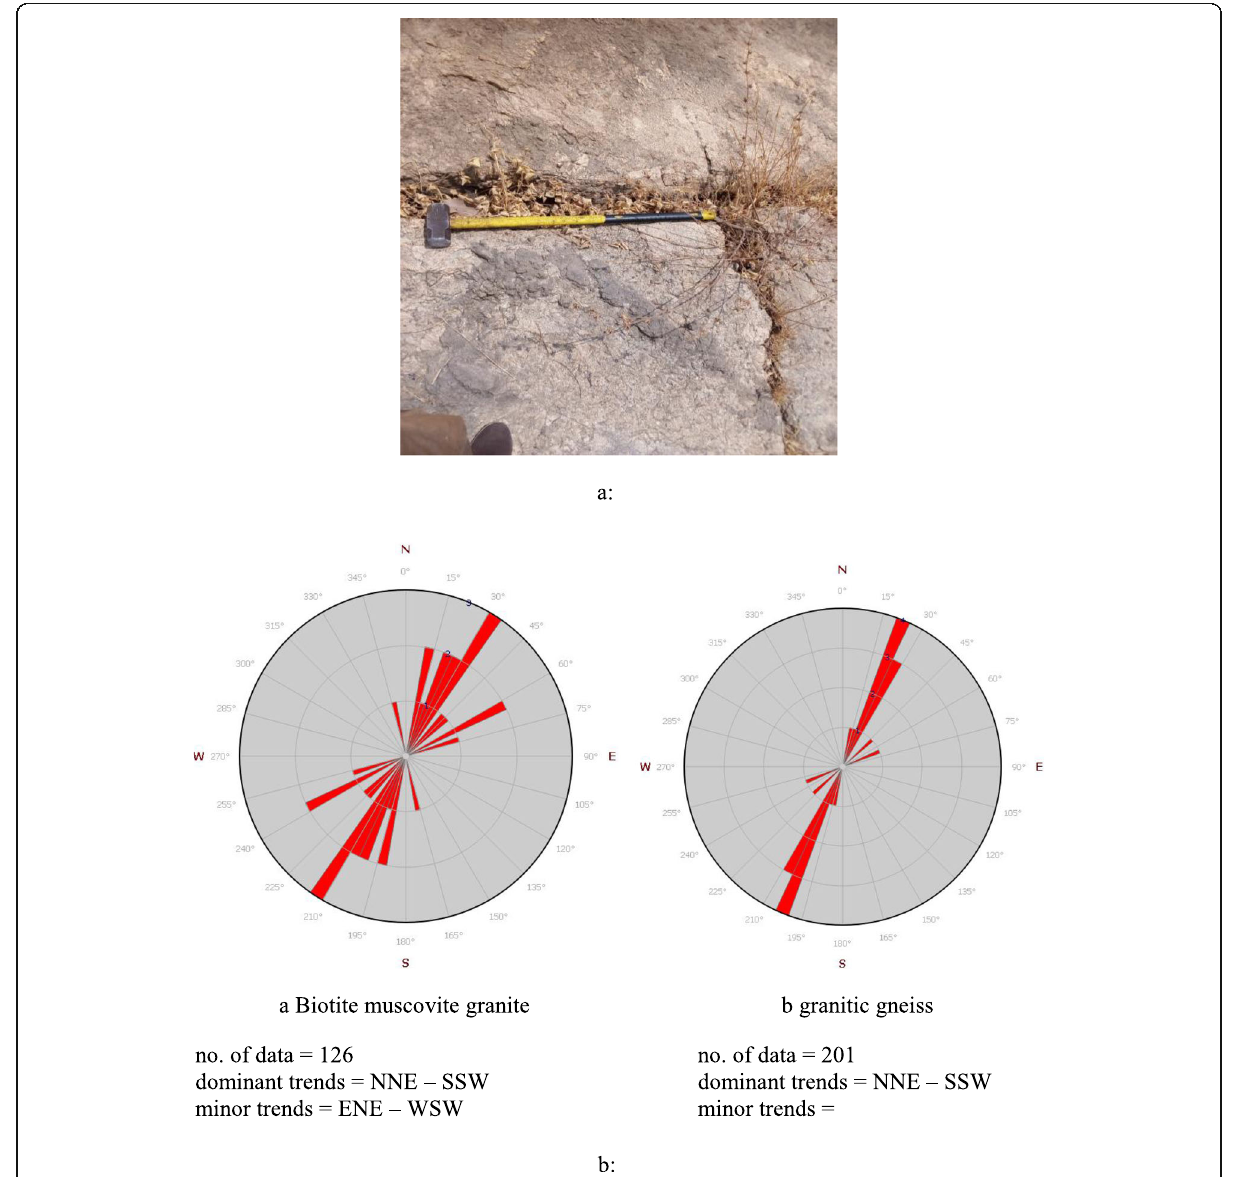
Fig. 10 a Photograph of Joints on granitic gneiss of the area. b Rose plot of joints on granitic gneiss and muscovite granite of the